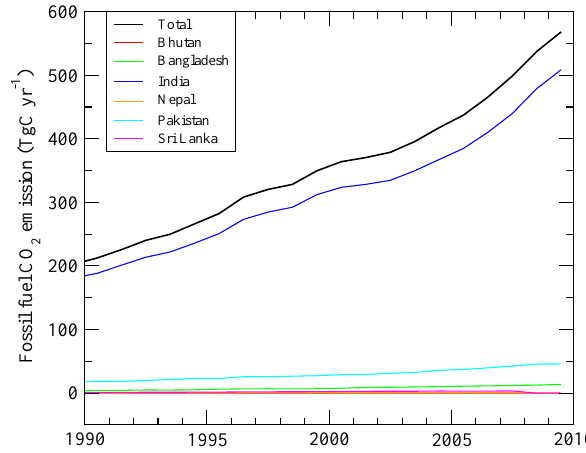
Fig. 2. Time series of CO 2 emissions due to fossil fuel consump- tion and cement production from the South Asian region during the period of 1990–2009 (source: Boden et al., 2011).